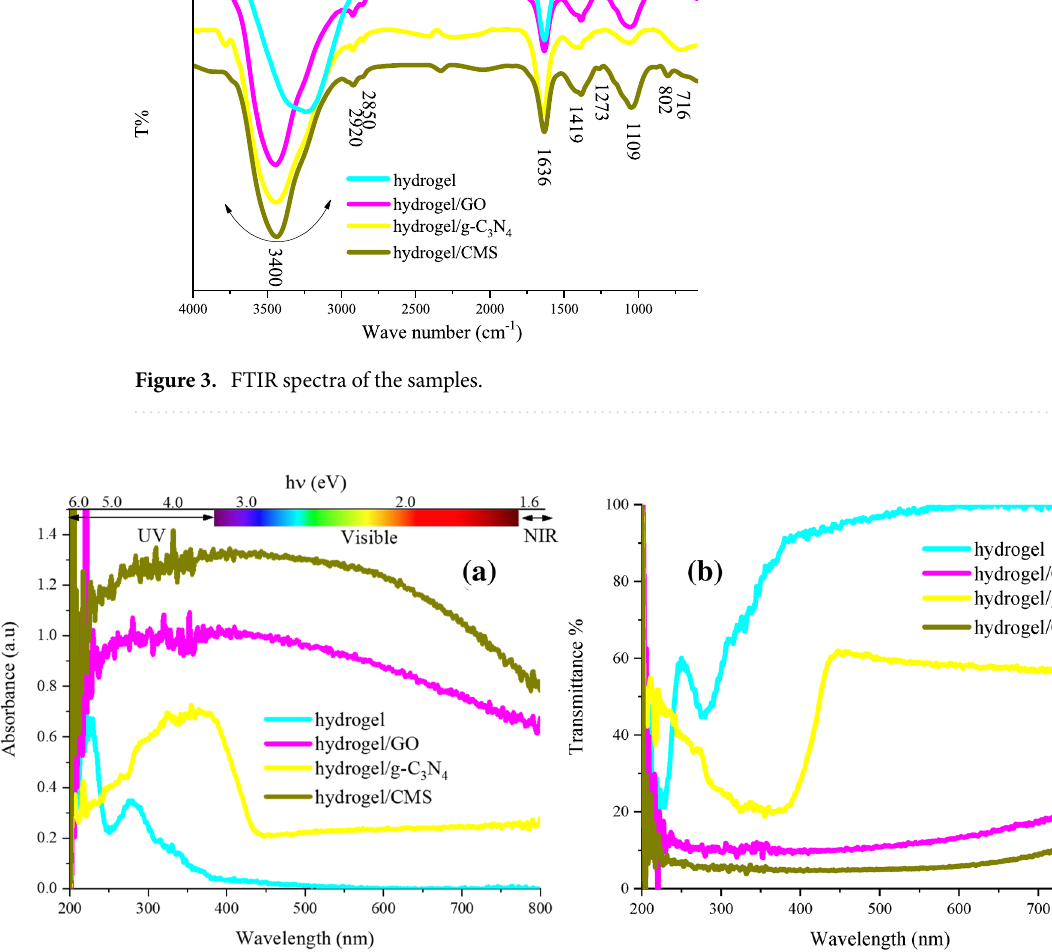
Figure 4. The light absorption ( a ) and transmittance % at λ = 200–800 nm ( b ) of the